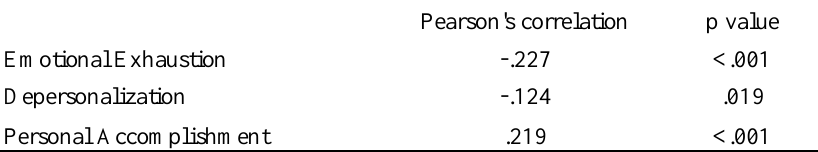
Correlations Between Perceived Support and Burnout Dimensions